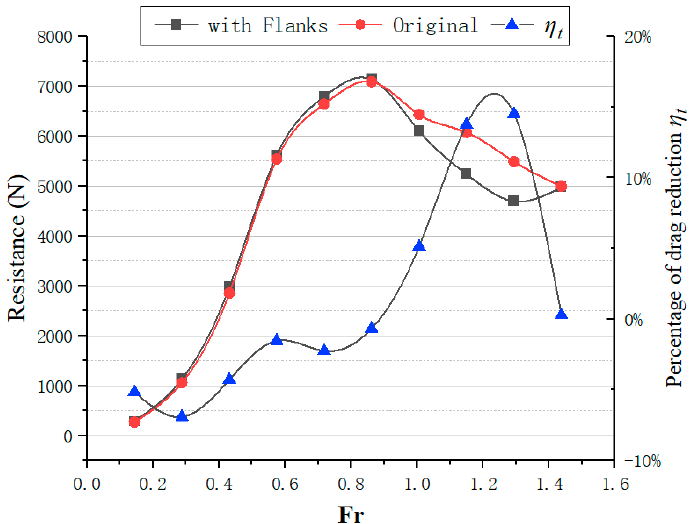
Figure 11. Comparison and drag reduction effect of the two schemes. r is used to describe the resistance ratio of / D t